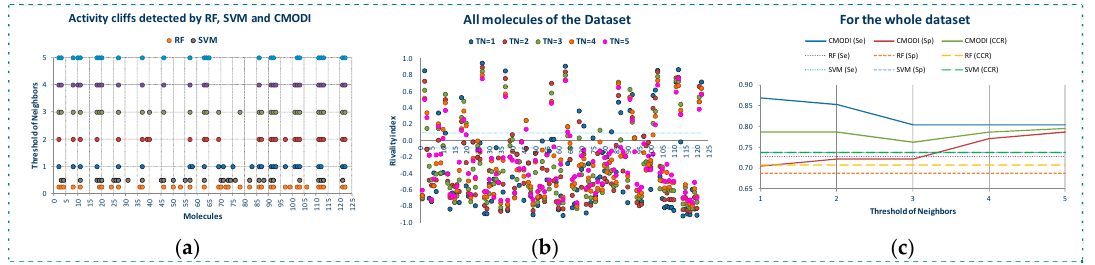
Figure 7. Activity cliffs detected by CMODI and outliers detected by RF and SVM algorithms ( a ), values of the rivality index for different values of TN ( b ), modelability values obtained by CMODI and the algorithms ( c ).